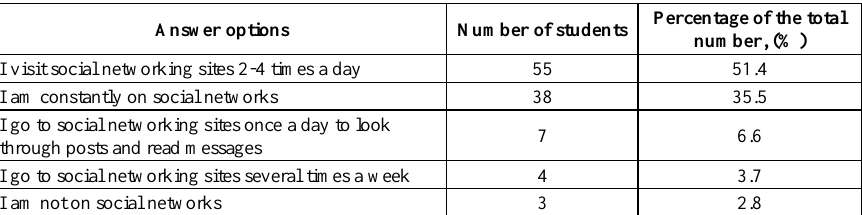
Table 2. Frequency of visiting social networking